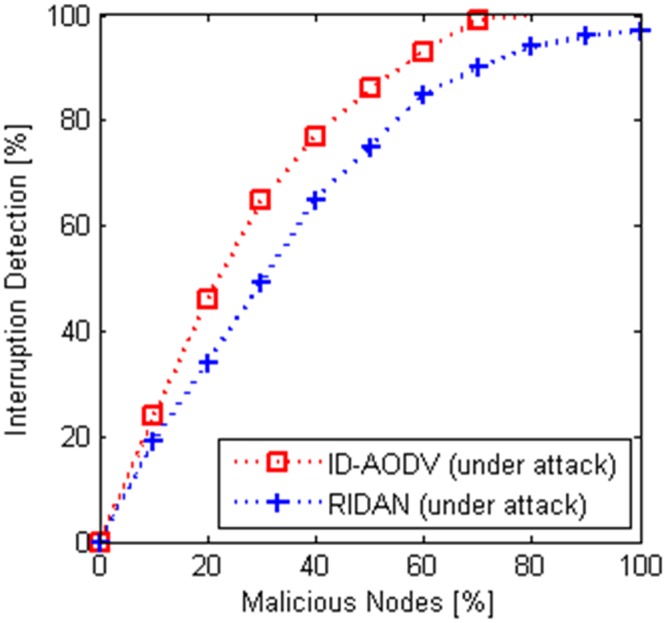
Comparative analysis of impact of percentage of malicious nodes on interruption detection under dynamic condition.